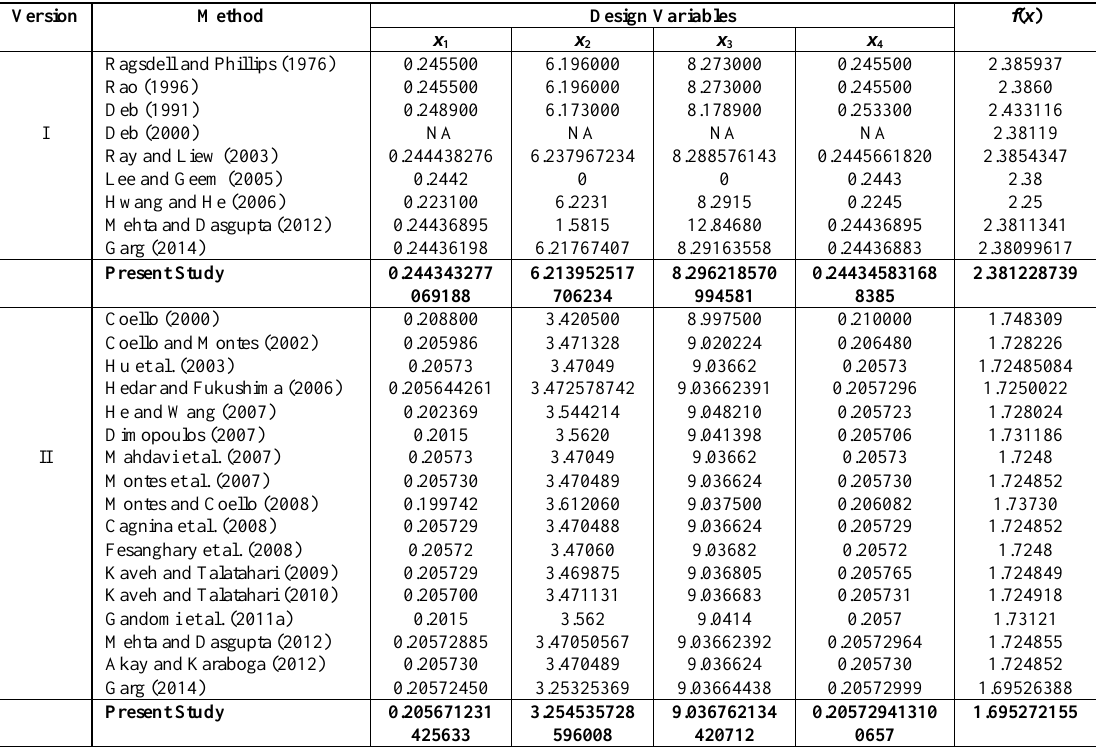
Table 3. Comparison of the best solution for welded beam design problem obtained by different methods